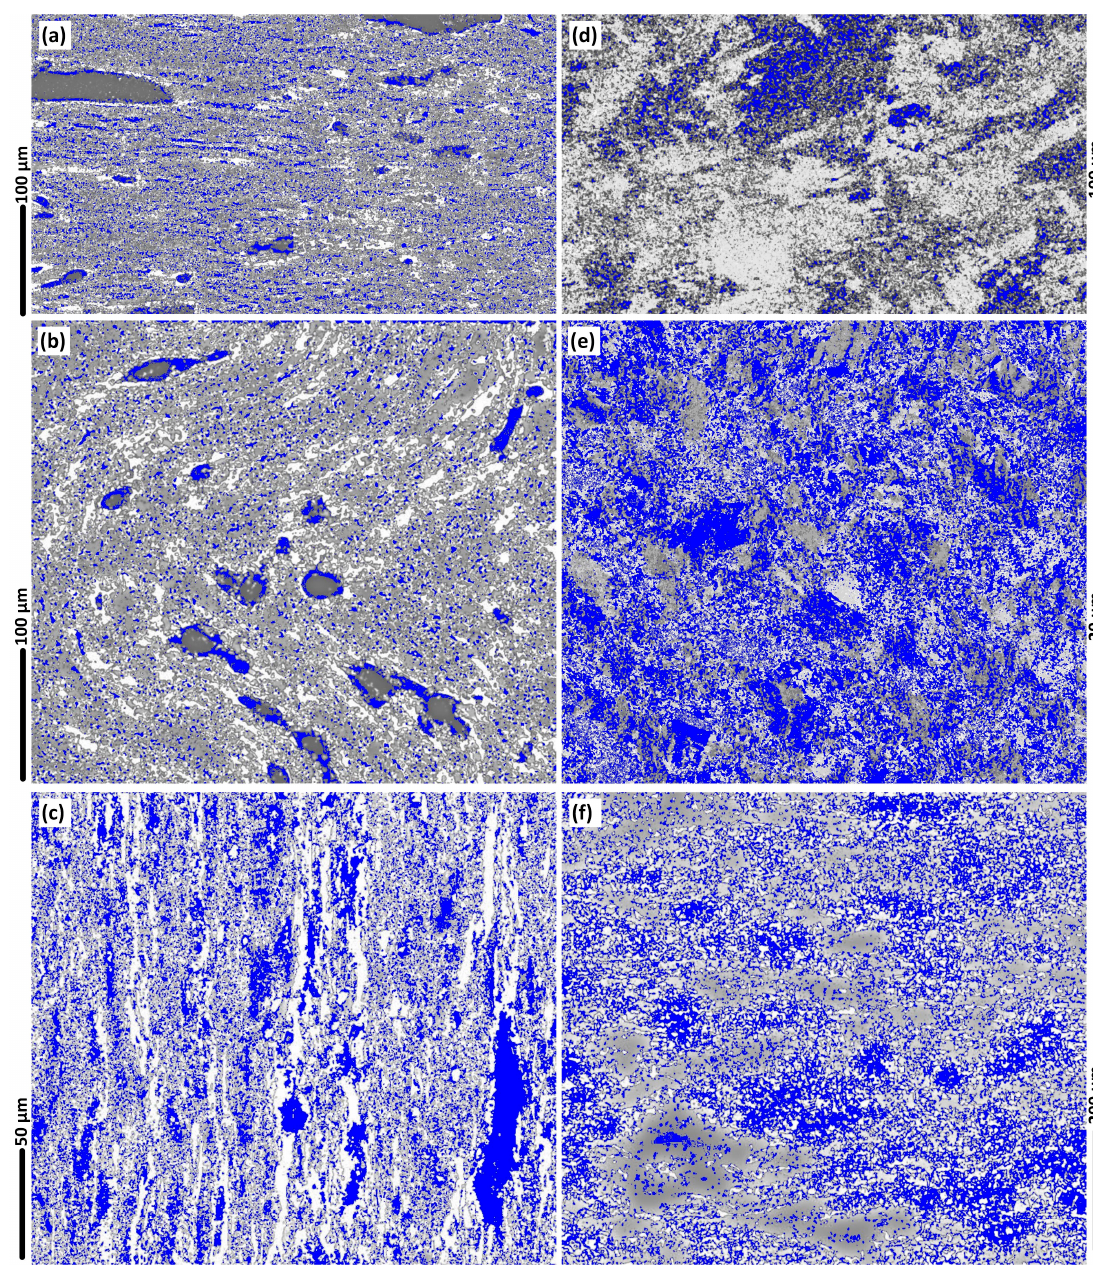
Figure 10. The micropatterns of the presence of low-angle grain boundaries (LAGBs, for 2°–10°) ( a – f ) in blue colour, for different regions of the weld; Base Metal (BM) ( a ); AS Hourglass border ( b ); Flow-arms ( c ); Sub-shoulder region ( d ); Mid-SZ ( e ); RS Hourglass border ( f ).